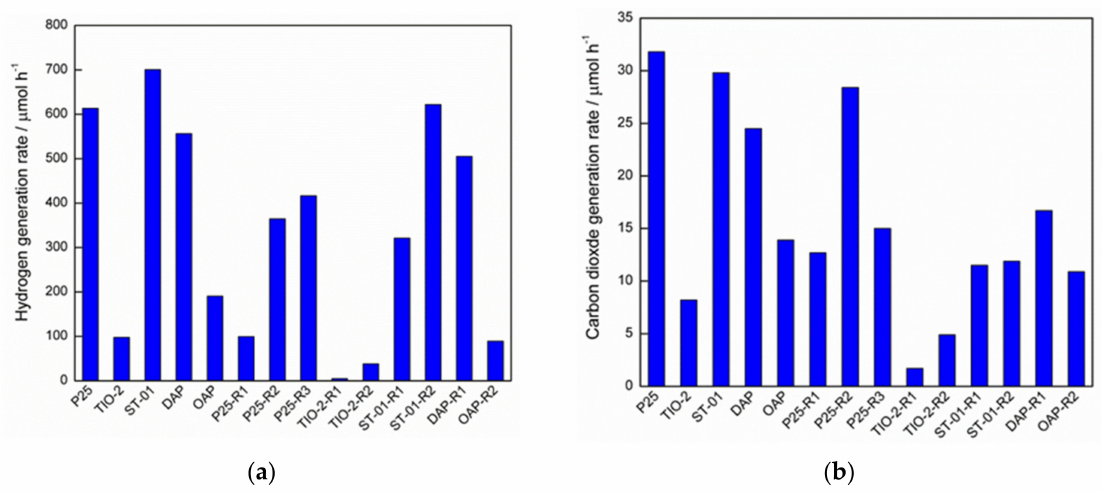
Figure 8. Photocatalytic activity under UV irradiation of pristine and reduced titania samples: ( a ) Methanol dehydrogenation (anaerobic conditions); ( b ) oxidative decomposition of acetic acid (aerobic